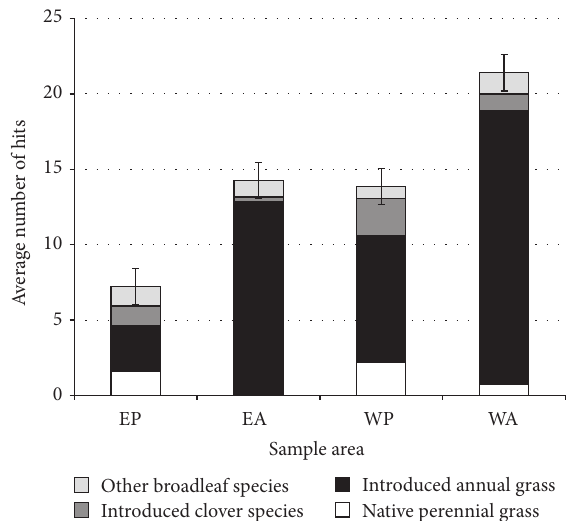
Figure2:Vegetativecover:averagenumberofhitsperpointquadrat frame on the four categories of groundcover vegetation for each sampling area. The error bars indicate the standard error of the average total number of hits per frame for all sample